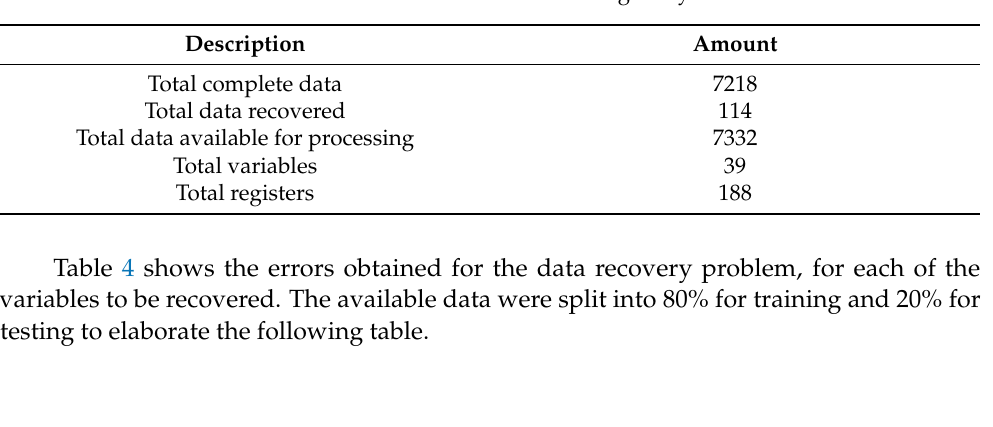
Table 3. Data recovered from the database for machine learning